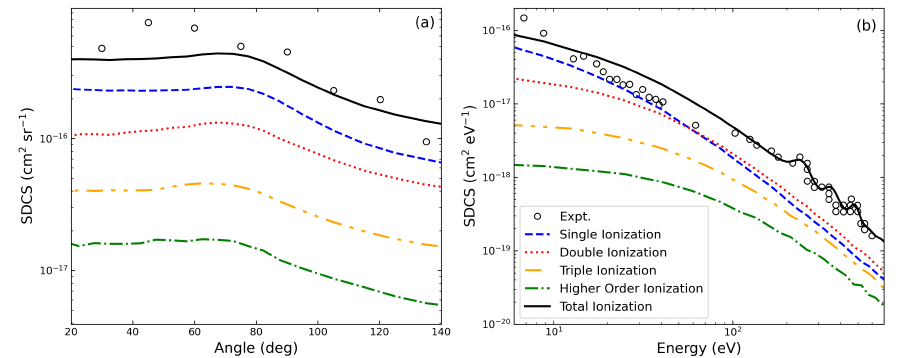
Figure 1. Ad-CTMC singly differential cross-section as a function of the electron emission angle ( a ) and energy ( b ). The experimental data correspond to Agnihotri et al. [21].